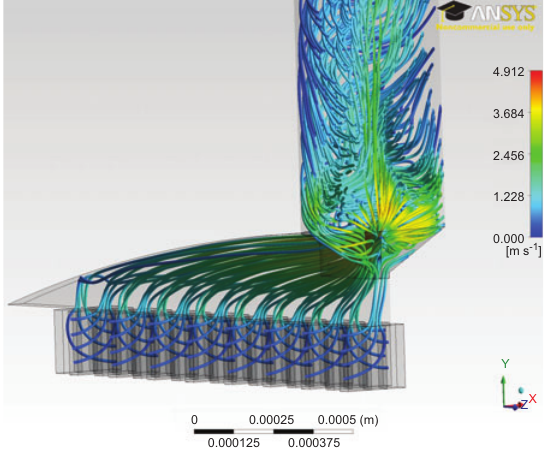
Figure 8 Flow conditions and concentration profi le within the = 0.03 interdigital mixer for m ˙ Init